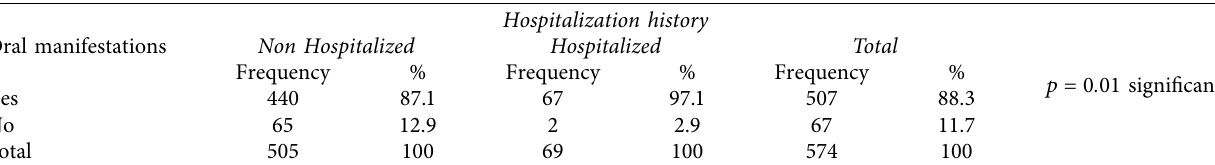
Table 5: Frequency, percentage, and the statistical diference of occurrence of oral symptoms in COVID-19 patients according to